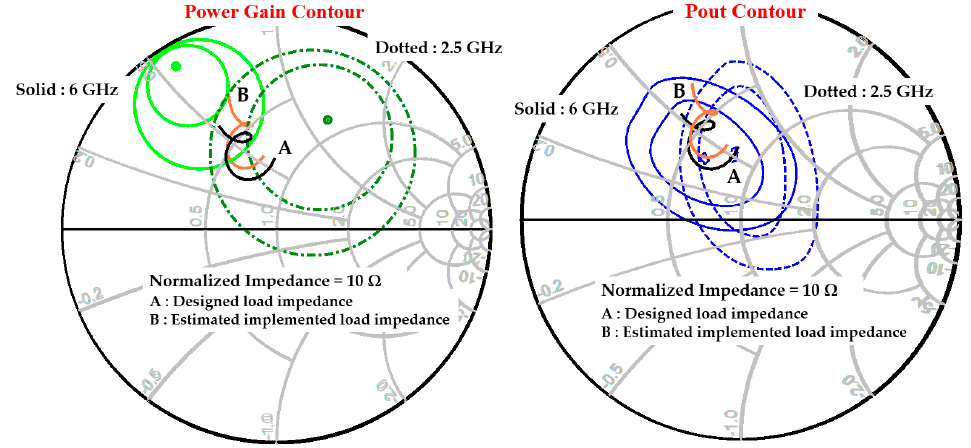
Figure 10. Designed and implemented load impedance traces with the power gain contours and the output power contours at 2.5 GHz and 6 GHz.